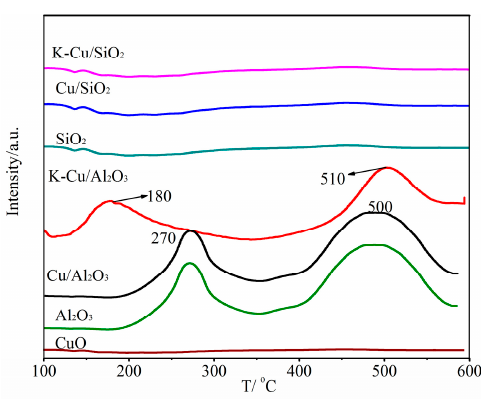
Figure 4. The temperature-programmed desorption of ammonia (NH 3 -TPD) profiles of Al 2 O 3 , SiO 2 , CuO, Cu/Al 2 O 3 , K-Cu/Al 2 O 3 and Cu/SiO 2 , K-Cu/SiO 2 catalysts .